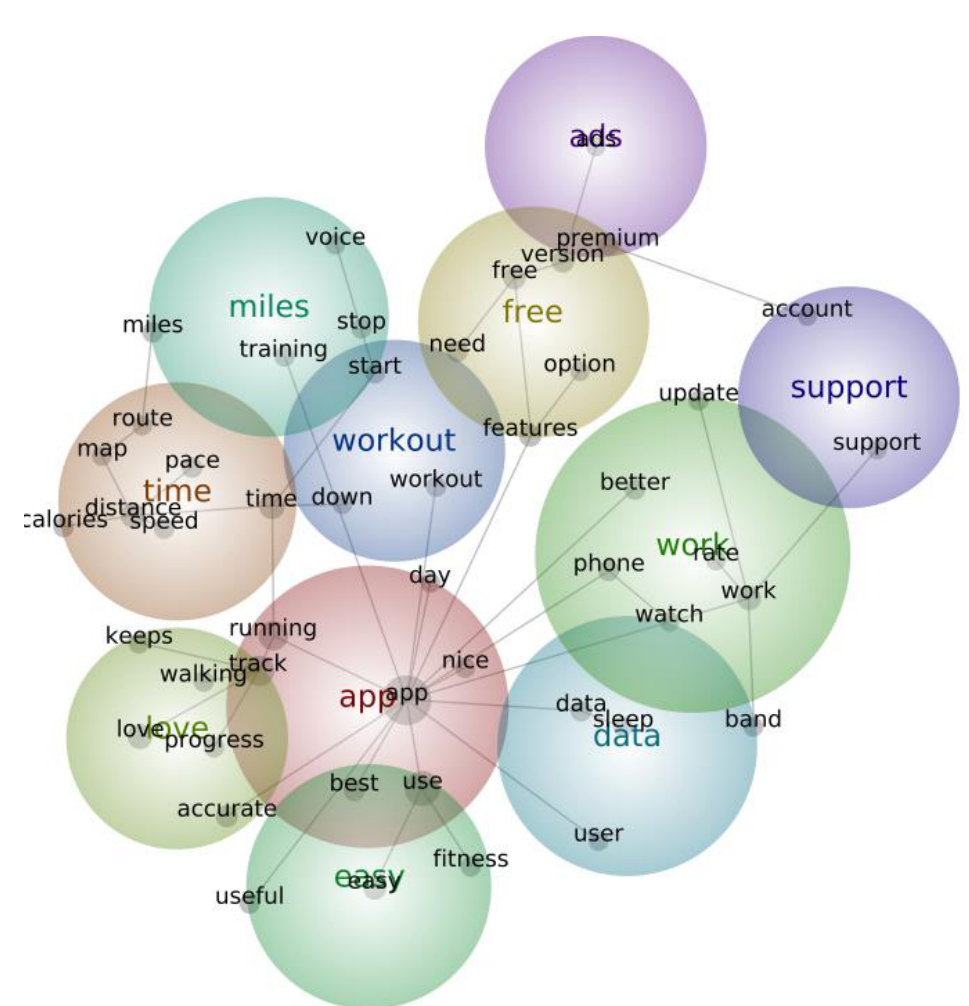
Figure 2. Theme map of users’ reviews of running